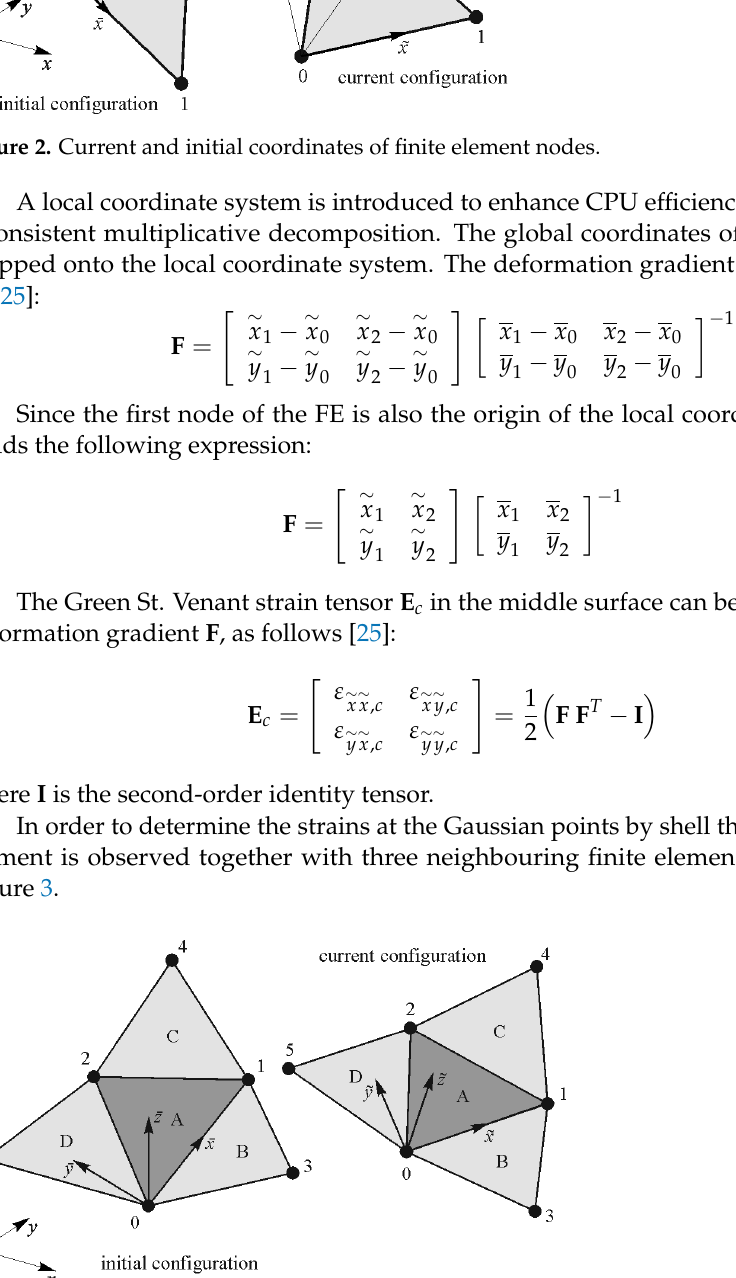
Figure 3. Current and initial configuration of the examined FE with adjacent FEs.